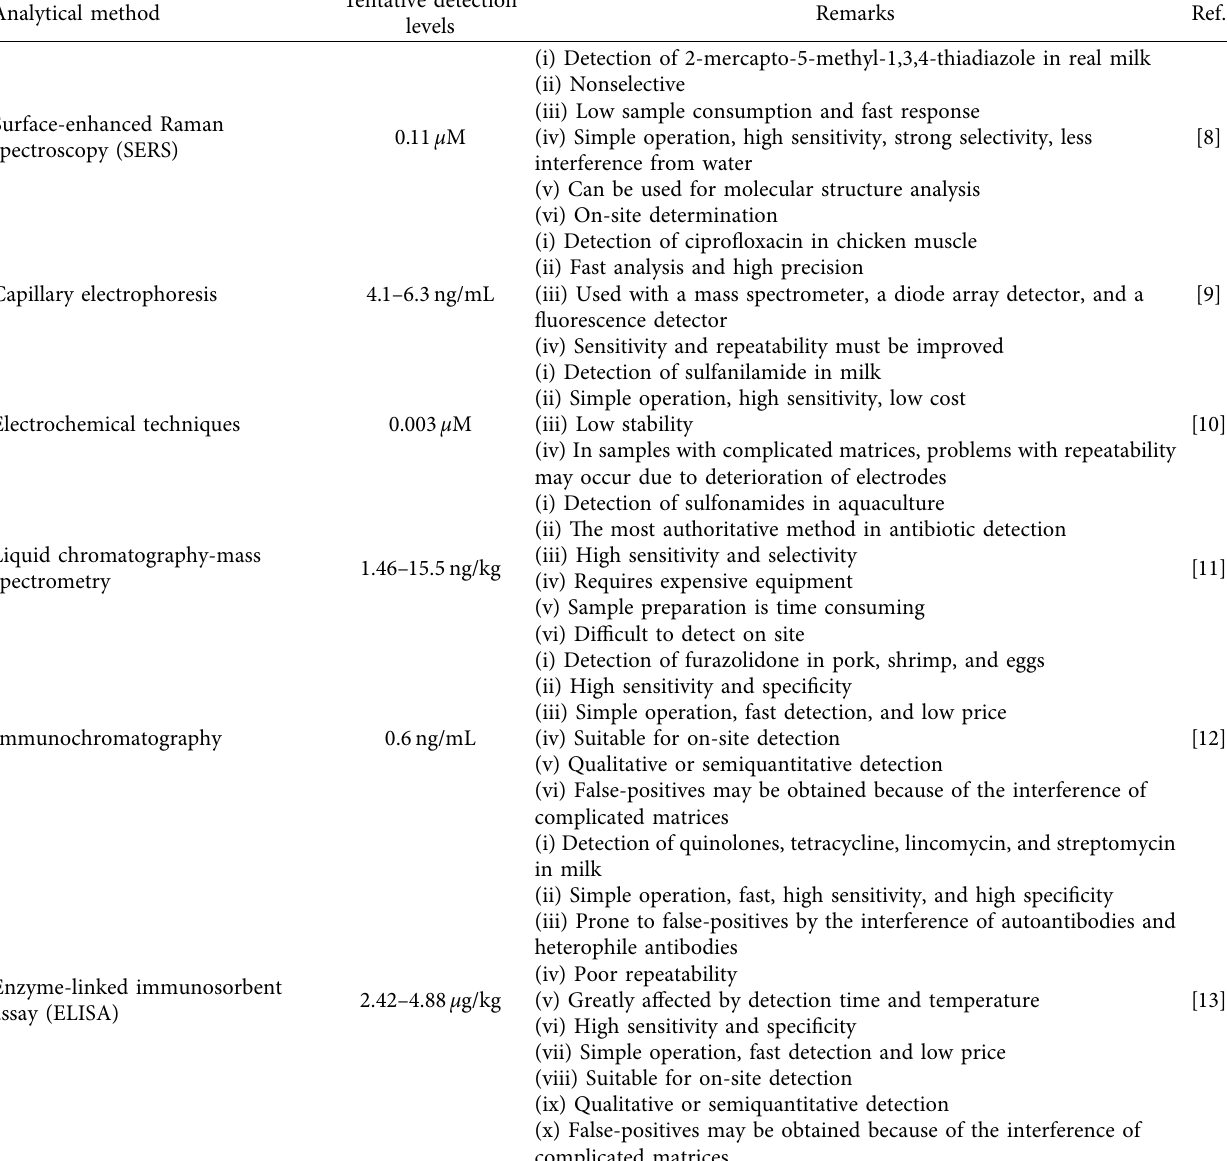
Table 1: Different analytical techniques for the determination of antibiotics in